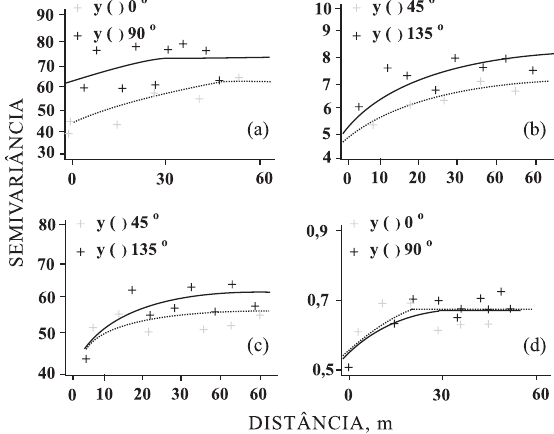
Figura 5. Modelos ajustados aos semivariogramas experimentais nas direções de anisotropia das variáveis Fe (a) e resíduos de MO (b), Mn (c) e H + Al (d).